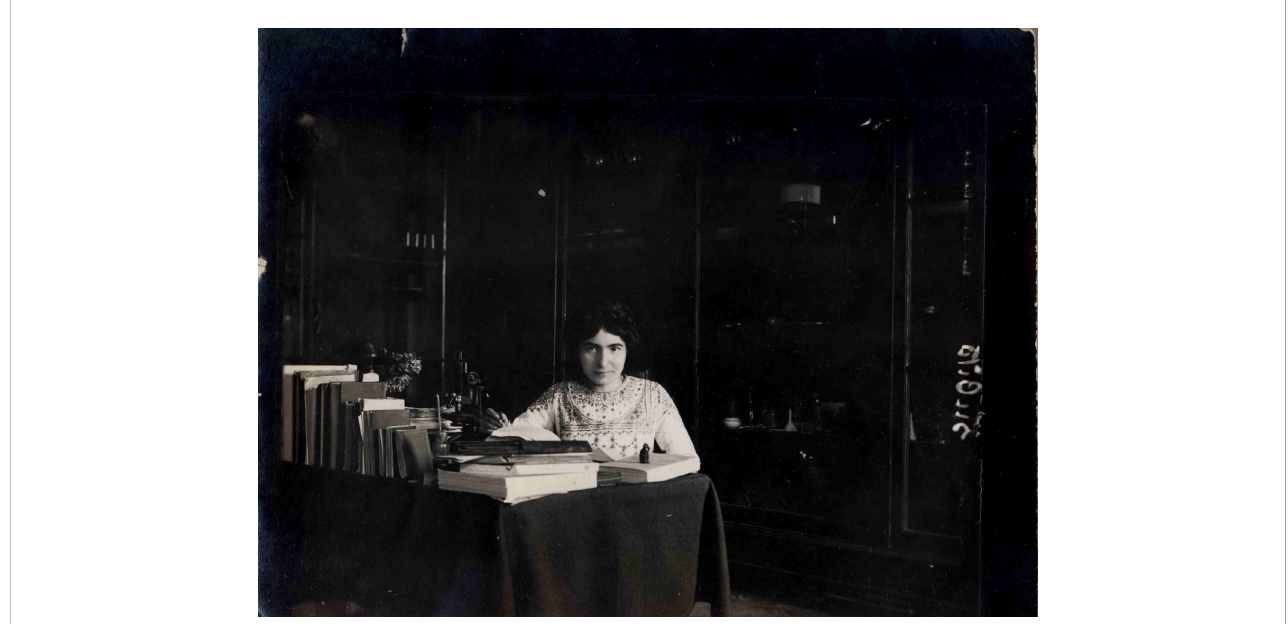
FIGURE 2 Eva Mameli Calvino at work (Courtesy of the Biblioteca Civica of Sanremo, Italy).